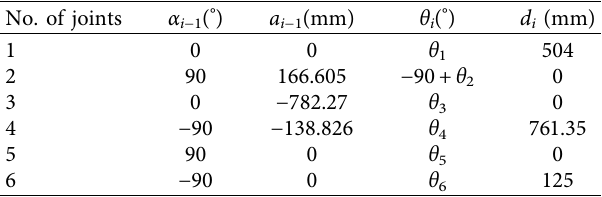
Table 1: Nominal values of robot’s MDH model parameters.